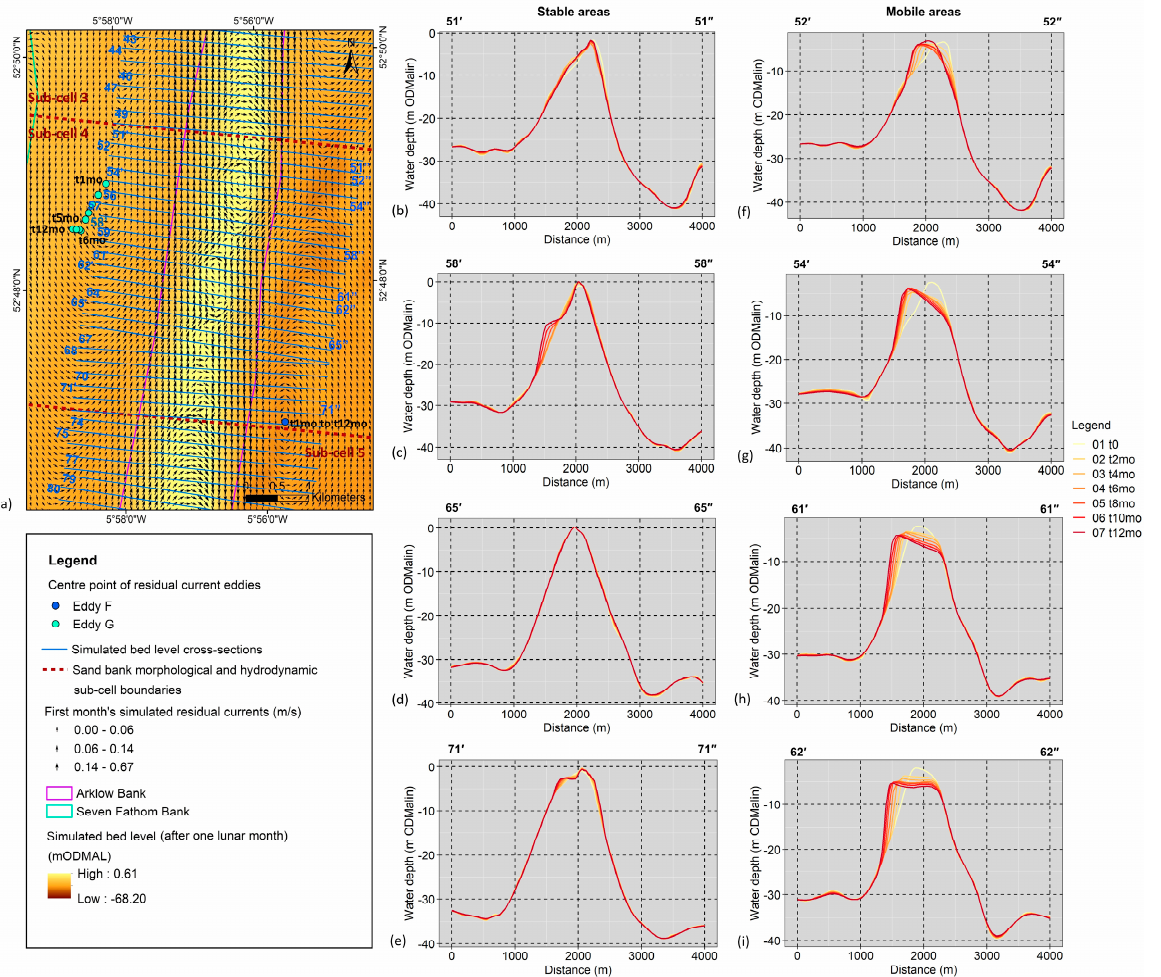
Figure 9. Morphodynamics and hydrodynamics at Sub-cell 4 of Arklow Bank. ( a ) Simulated bed level change after one lunar month and associated residual current vectors, overlain by the location of the centre point of residual eddies from residual currents during each subsequent lunar month simulation; ‘t6mo’ is the sixth lunar simulation month. ( b – e ) Simulated bed level over a one year simulation at cross-sections 51, 58, 65 and 71, representing ‘stable’ areas; ‘t0 ′ is the starting bed level and ‘mo’ is subsequent months; ( f – i ) cross-sections 52, 54, 61 and 62 representing ‘mobile’ areas. The line of intersection of Eddy F and Eddy G gives rise to a complex hydrodynamic region of constant and transient on-bank clockwise residual eddies, where the centre point and the intersection point of the individual eddies are dominated by reduced residual current magnitudes and quantity of cross-flow. These points are intermixed with rela- tively higher eastward and westward residual cross-flows that increase outwards from the centre point of each eddy. This sequence of residual clockwise eddies along this section